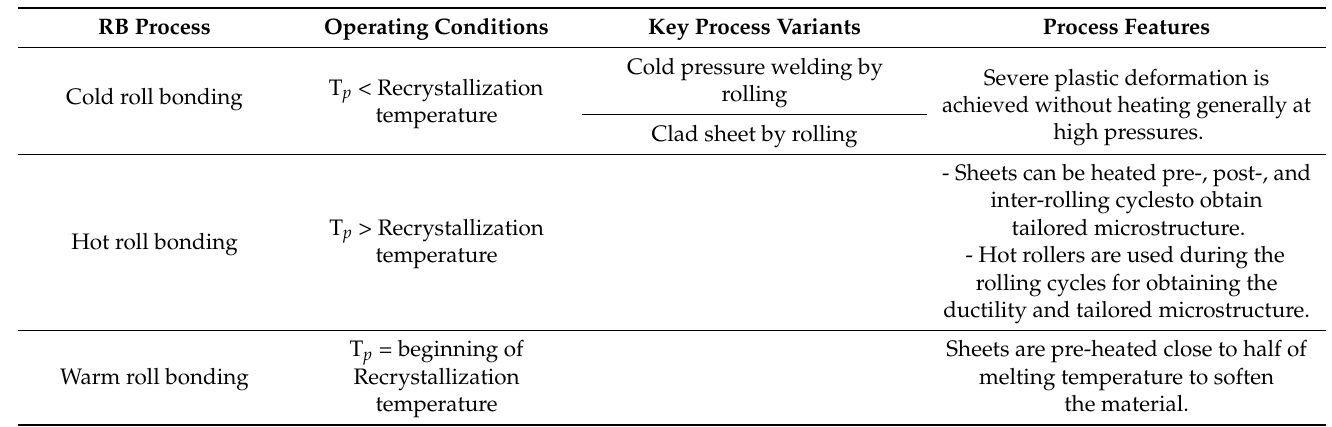
Figure 2. Schematic diagram of the ARB process. Table 1. Comparison of roll bonding (RB) processes.